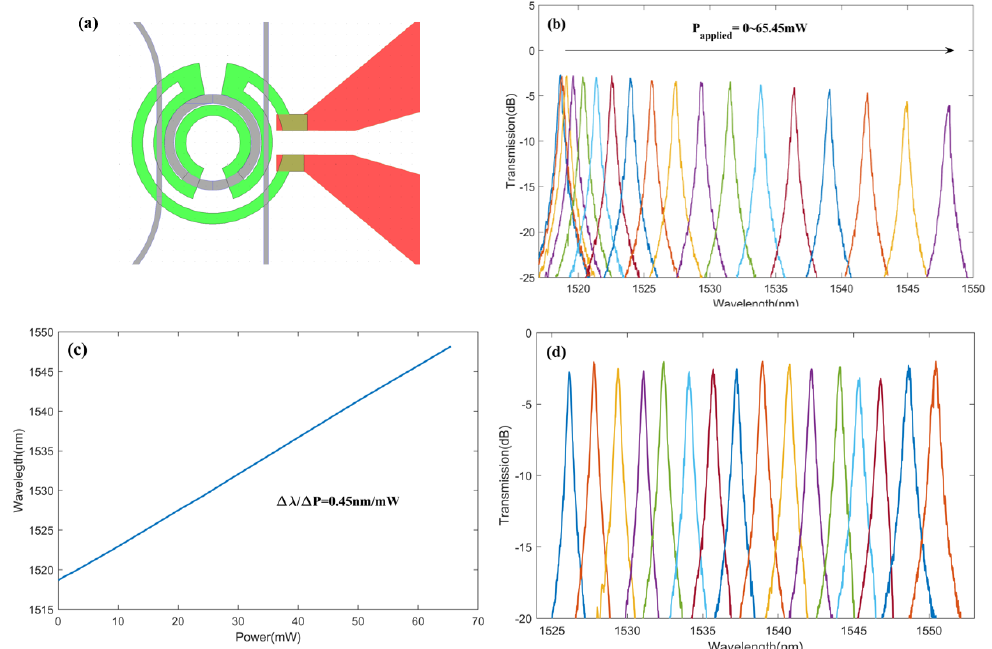
Figure 7. ( a ) Schematic of micro-heater (green) and waveguides (grey), ( b ) measured spectral responses of one MRR with different applied power, ( c ) wavelength shift as a linear function of power, ( d ) measured spectral responses of one mode channel where signals are demultiplexed by WDM channels under thermal